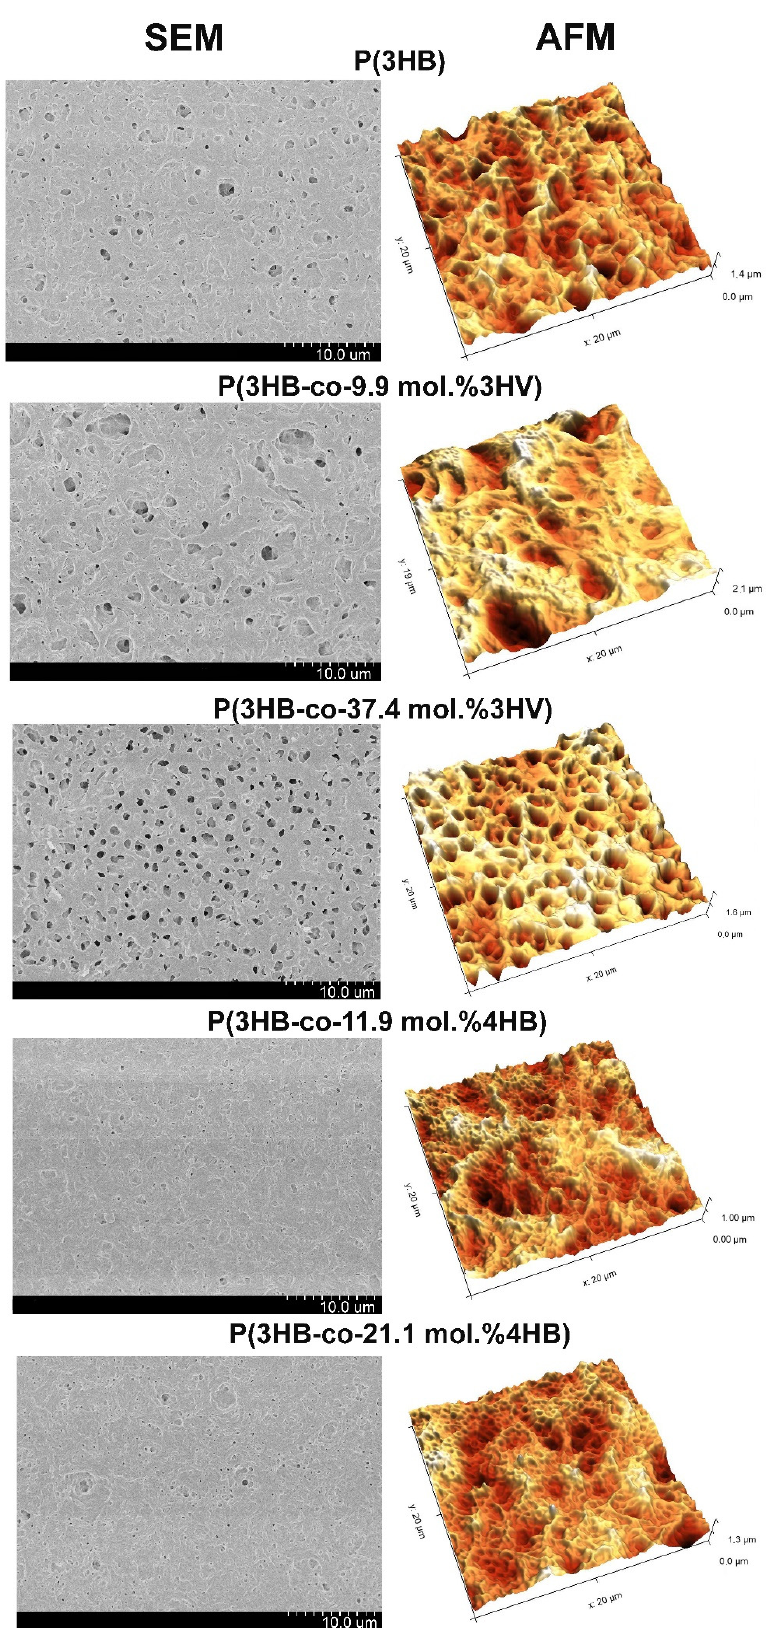
Figure 6. SEM and AFM images of PHA specimens synthesized from JA